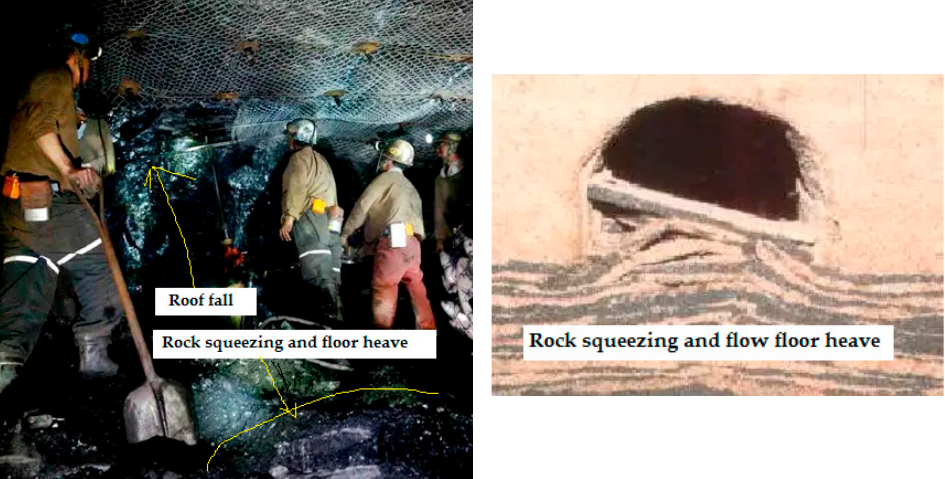
Figure 2. The roadway roof fall and flow floor heave with rock squeezing.